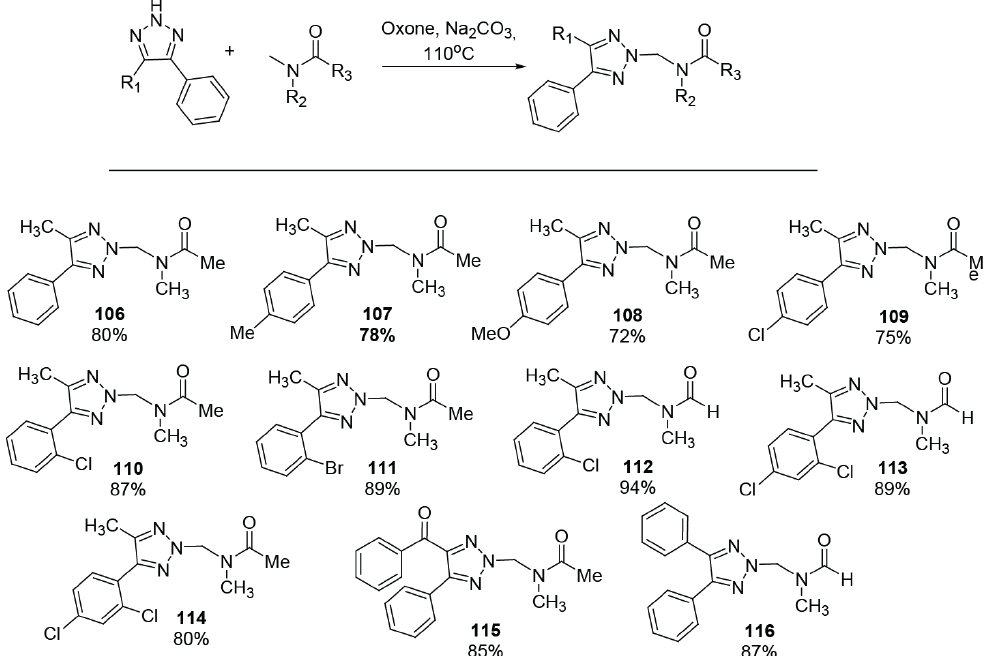
Figure 17 - Regioselective cross-dehydrogenative coupling (CDC) between Nh-1,2,3-triazoles and N,N- dialkylamides.